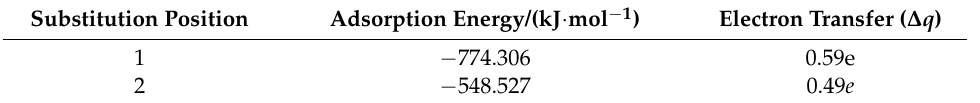
Table 4. Effect of the replacement of Ce with La on the bastnaesite (100) surface on the adsorption energy. Substitution Position